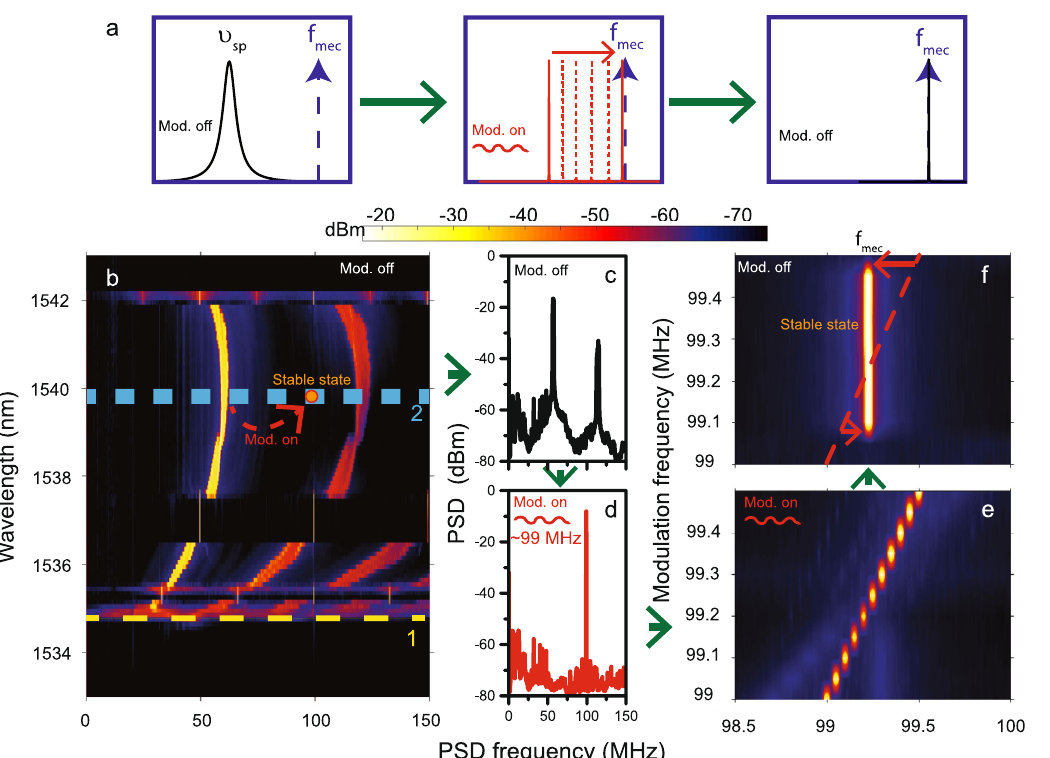
Fig. 4 Exploitation of injection locking to reach a mechanical lasing state. a Scheme of the experiment. b Colour contour plot of the power spectral density (PSD) spectra as a function of the laser (L1) wavelength ( λ L1 ) when the modulation is off. The horizontal dashed line denoted by 1 (yellow) indicates the threshold for the self-pulsing activation, while that denoted by 2 (cyan) refers to the con fi guration associated to rest of the panels of this fi gure. The PSD power is quanti fi ed in dBm with the same colour scale as in Fig. 3a. c , d PSD spectrum when the modulation is off ( b ) and on at about 99 MHz and P = ±13% ( c ). Colour contour plot of the PSD spectra as a function of the modulation frequency when the modulation is on ( e ) and after it has been mod switched off ( f ). The dashed line in ( f ) indicates the frequency of the state when the modulation was on. The PSD power of ( b ), ( e ) and ( f ) is quanti fi ed in dBm in the colour